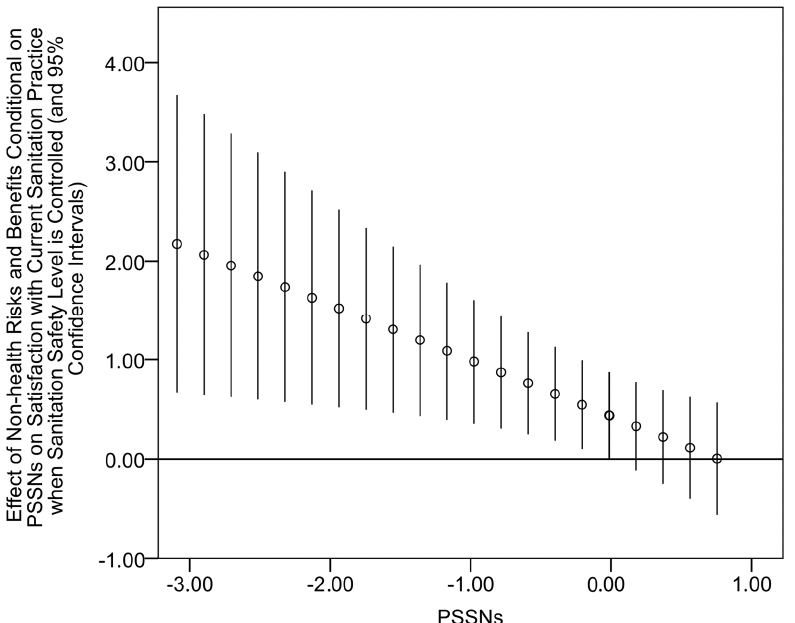
Figure 7. Effects of perceived non-health risks and benefits on satisfaction with current sanitation practice when sanitation safety is controlled conditional on different values of PSSNs (small circles) and their 95% confidence intervals.